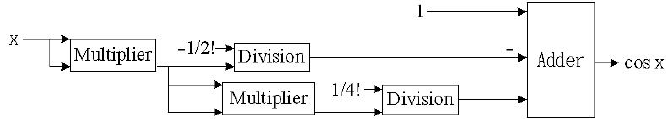
Figure 12. Block diagram of the cosine function with the Taylor expansion.